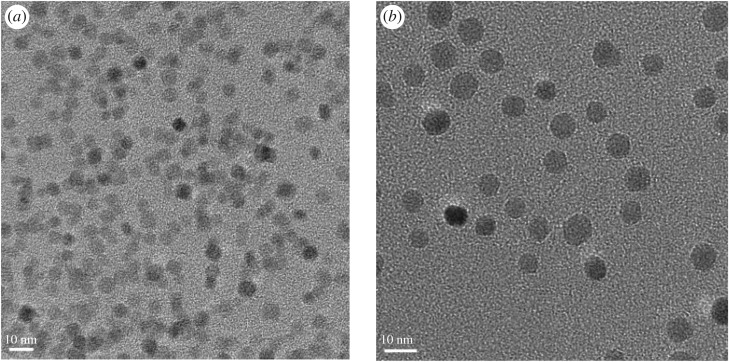
TEM images of Fe3O4 NPs of (a) 5 nm average diameter and (b) 8 nm average diameter.